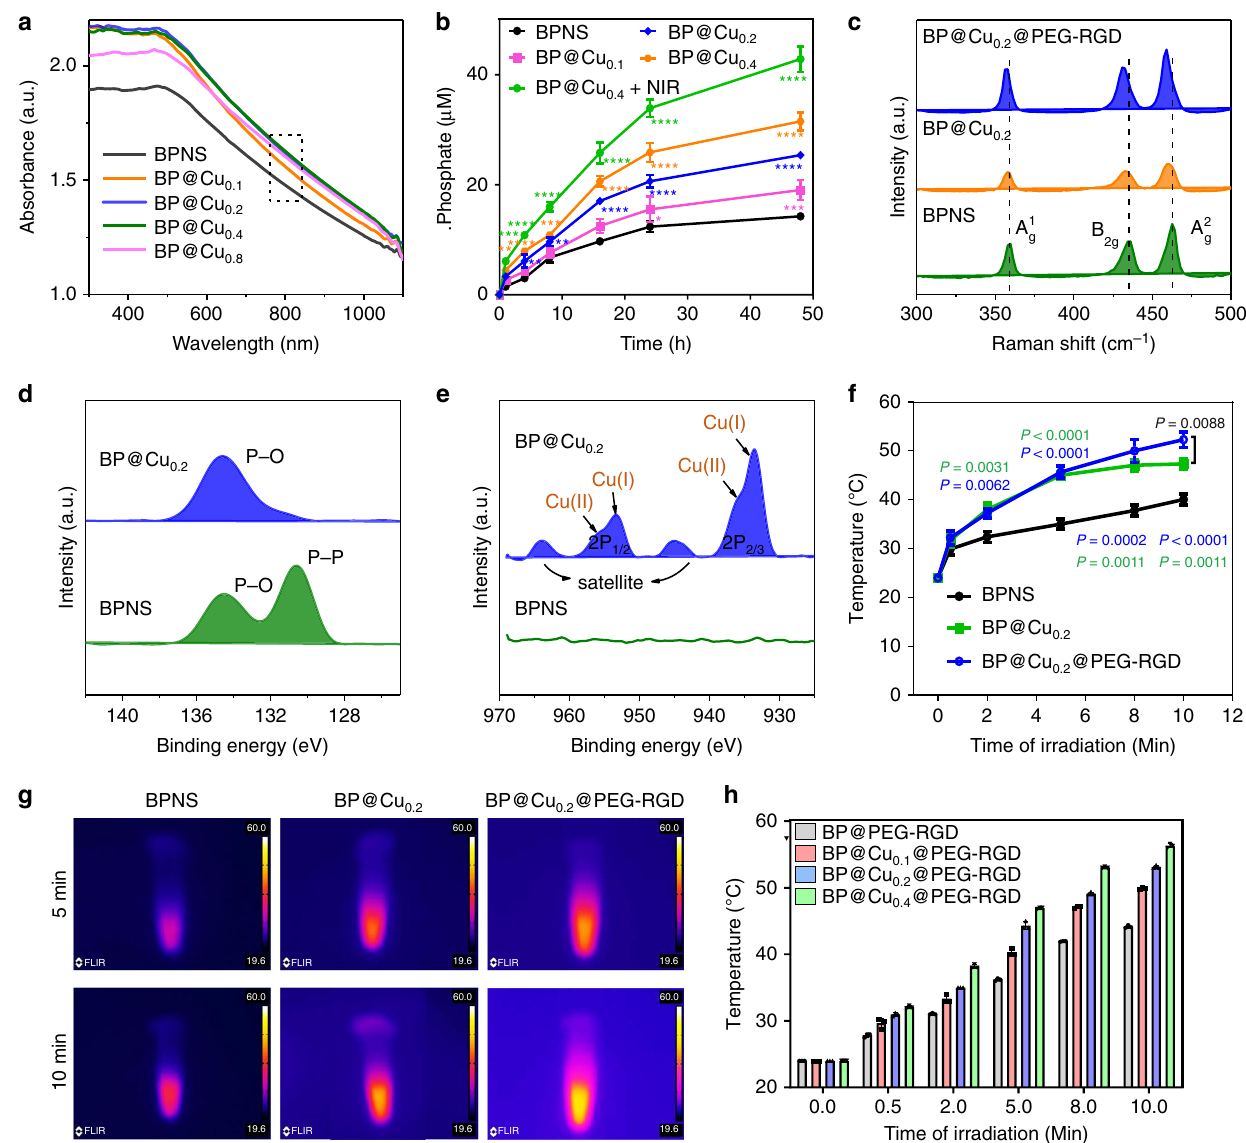
Fig. 3 In fl uence of Cu 2 + ions on the stability and photothermal effects of BPNS. a UV – vis absorbance spectra of BPNS, BP@Cu 0.1 , and BP@Cu 0.2 and BP@Cu 0.4 with the same amount of BPNS (100 ppm). b Measurement of phosphate anions by phosphate assay kit. Degradation of BPNSs and BP@Cu x with the same amounts of BPNS (50 ppm) after storage in water for different periods, producing increasing concentrations of phosphate anions in the supernatant. The data show mean ± s.d. n = 3. * P < 0.05, ** P < 0.01, *** P < 0.001, **** P < 0.0001, analyzed by one-way ANOVA, followed by Tukey ’ s multiple comparisons post-test. c Raman scattering spectra of BPNS, BP@Cu 0.2 , and BP@Cu 0.2 @PEG-RGD. d High-resolution XPS spectra showing the binding energies of P 2p of BPNS and BP@Cu 0.2 . e High-resolution XPS spectra showing the binding energy of Cu 2P of BPNS and BP@Cu 0.2 . f Photothermal heating curves recording the temperature variations of BPNS, BP@Cu 0.2 , and BP@Cu 0.2 @PEG-RGD with the same amount of BPNS (20 ppm) dispersed in PBS. The data show mean ± s.d., n = 3. P values marked in green and blue colors indicate statistically signi fi cant differences compared with the BPNS group. P values marked in black value indicates statistically signi fi cant differences between BP@Cu 0.2 and BP@Cu 0.2 @PEG-RGD. Analyzed by one-way ANOVA, followed by Tukey ’ s multiple comparisons post-test. g Infrared thermographic maps of BPNS, BP@Cu 0.2 , and BP@Cu 0.2 @PEG-RGD with the same amounts of BPNS (20 ppm) in tubes after irradiation for 5 and 10 min under the 808 nm laser (1 W cm − 2 ). h The temperature increments of different BP@Cu x @PEG-RGD samples under NIR laser irradiation by an 808 nm laser for different periods. The data represents the mean ± s.d. of three independent